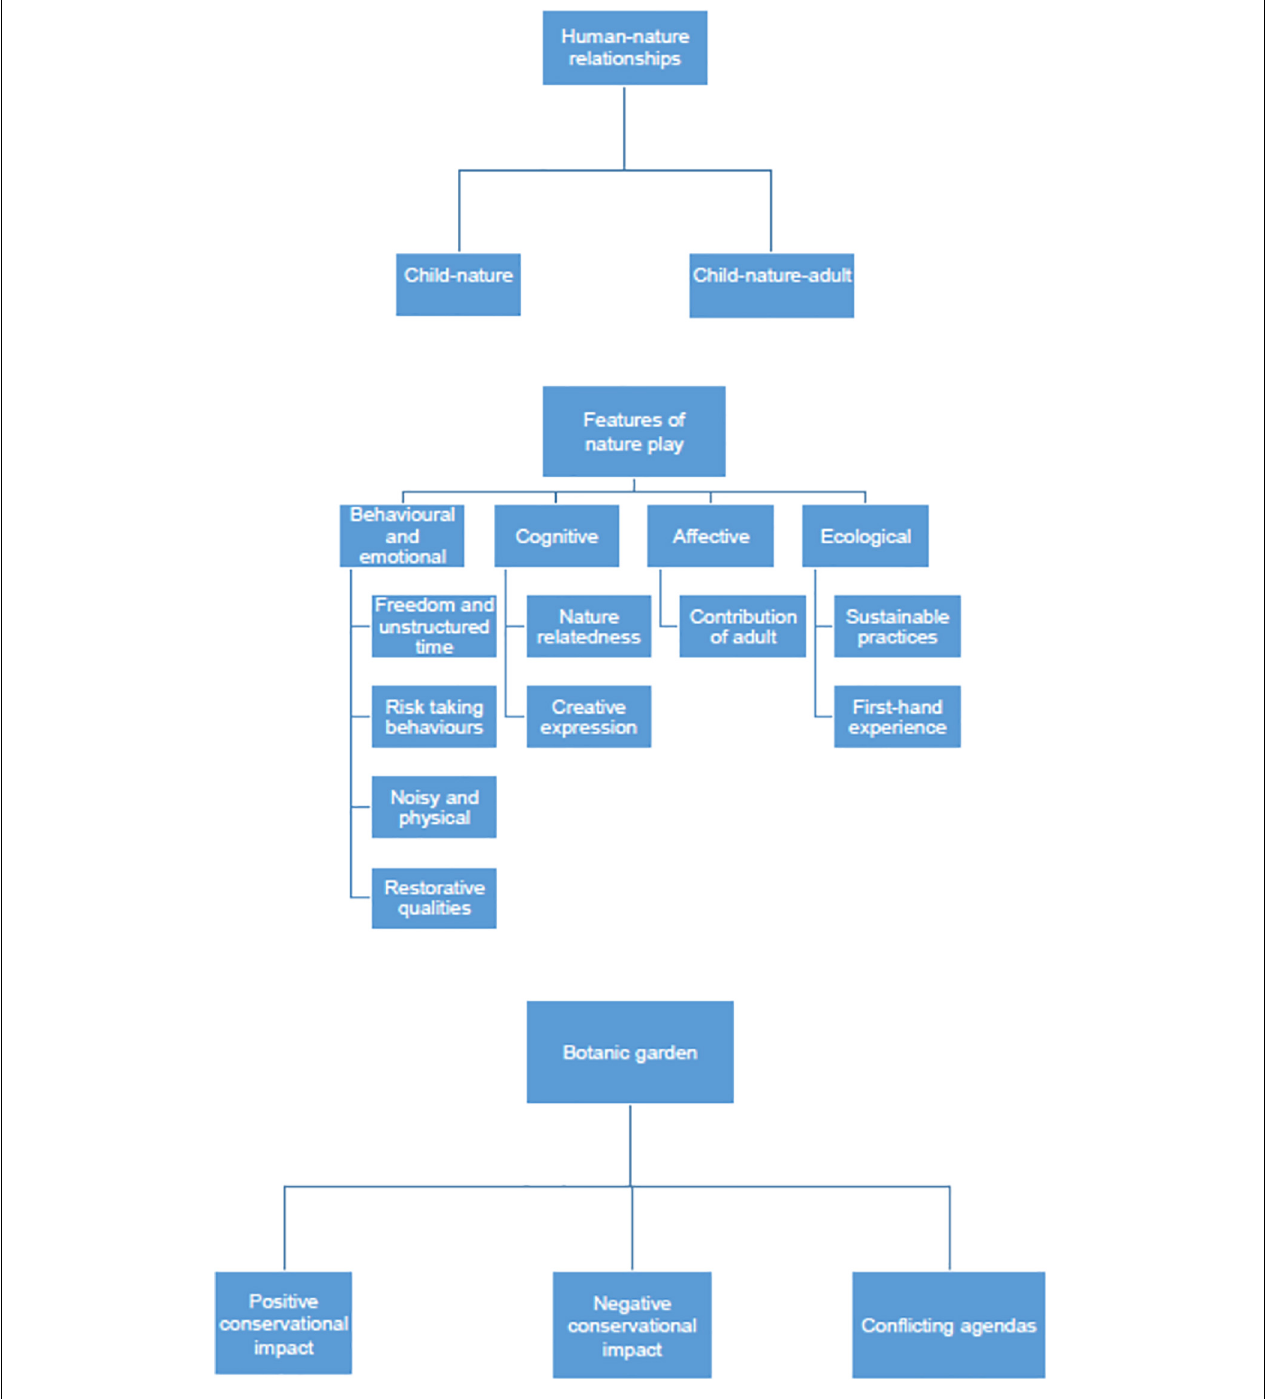
FIGURE 1 | Visual illustration of the thematic